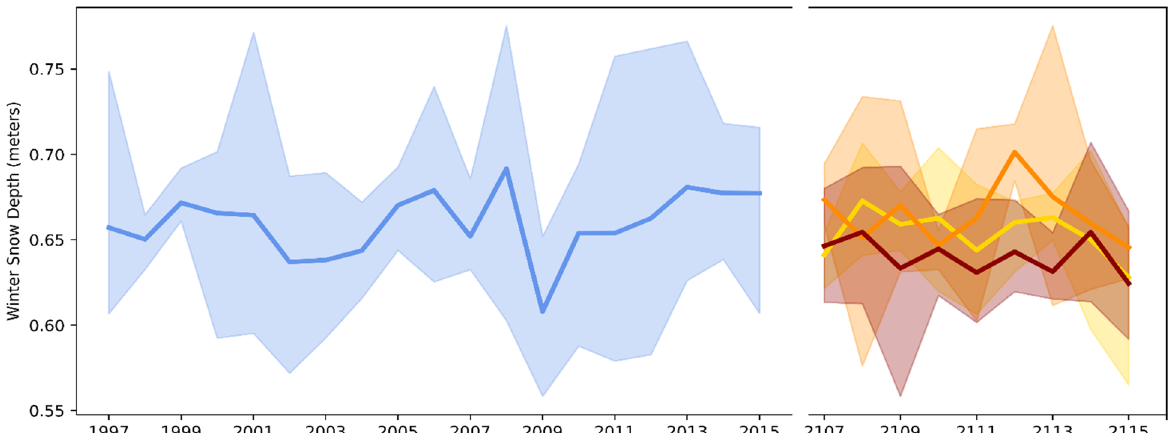
Figure 10. December–February snow depths averaged over Alaska in the HAPPI historical simulations (left) and the future projections (right). Solid lines are ensemble means, whereas shading denotes the range among the ensemble members. The future projections are shown in progressively darker shades for the global warming scenarios of 1.5 °C, 2.0 °C and 3.0 °C.